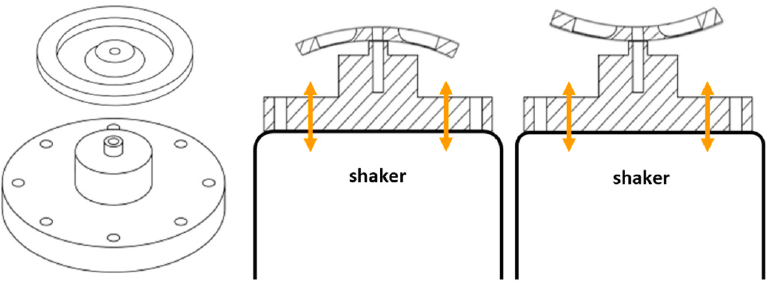
Figure 5. Testing system with a circular plate specimen excited by a uniaxial shaker (reprinted from [35], with permission from Elsevier, 2021).